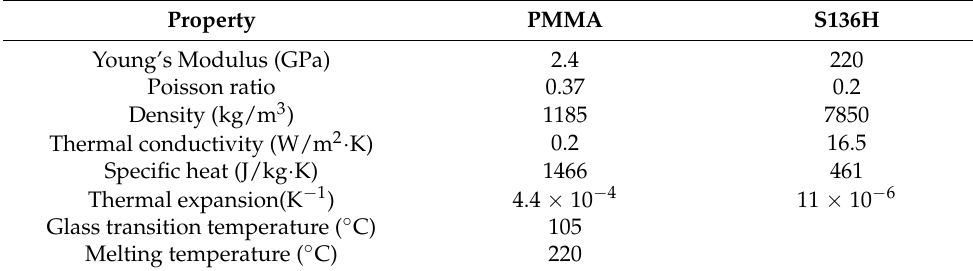
Table 1. Physical properties of PMMA and S136H die steel. Property